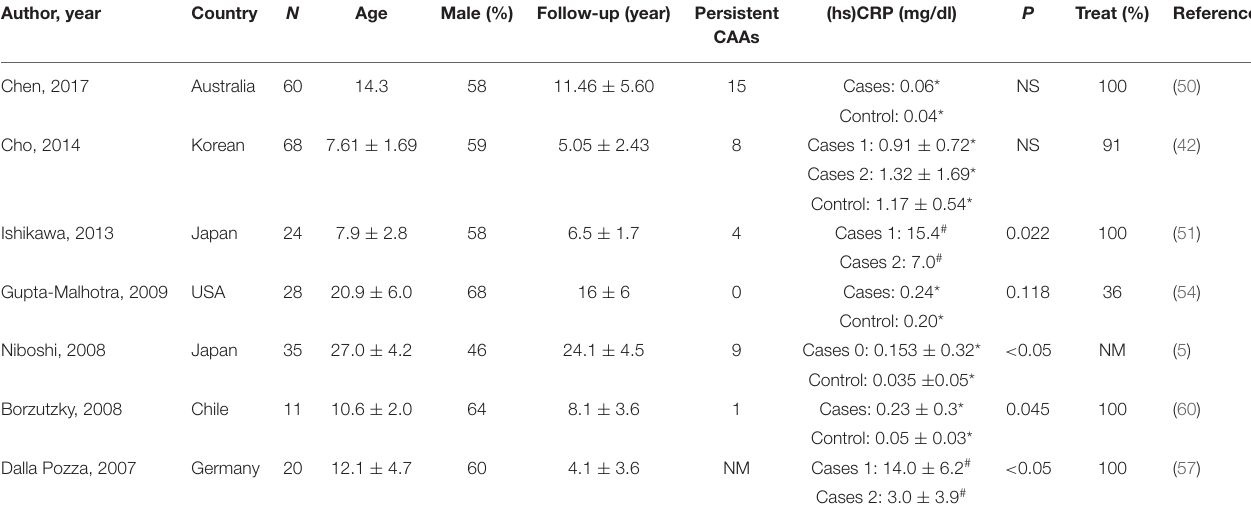
TABLE 4 | Studies on C-reactive protein (CRP)/high-sensitive C-reactive protein (hsCRP) in patients with a history of KD. Author,